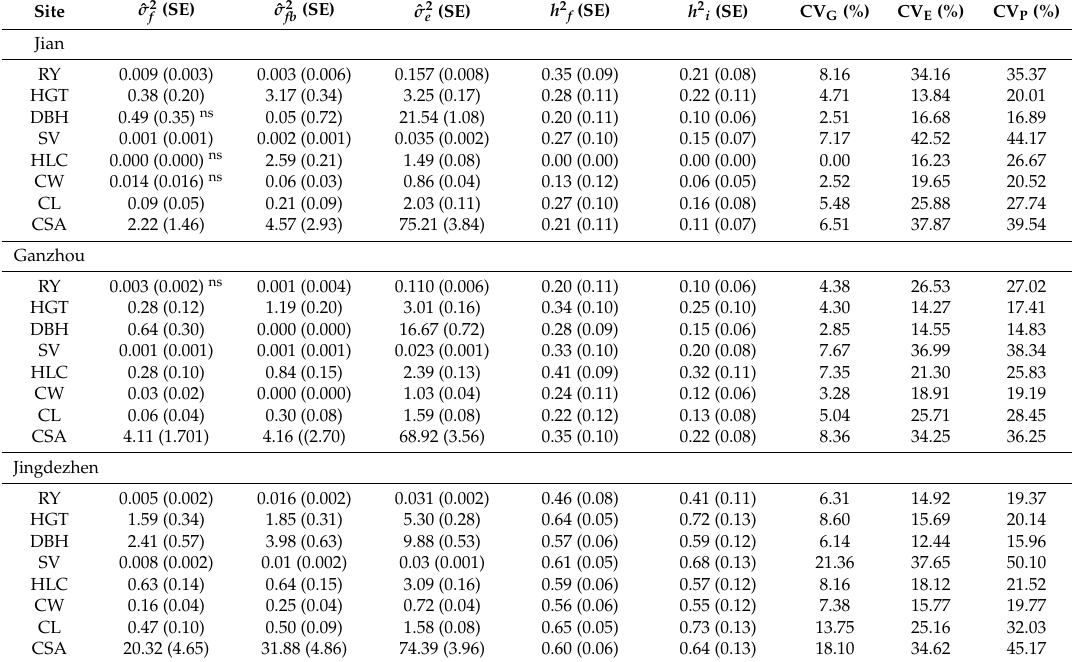
Table 4. Estimates of variances (ˆ σ 2 family mean and individual narrow sense heritability (ˆ h 2 coefficient of variation at genetic, phenotypic and residual level (CV G , CV P and CV E ) for various traits at each